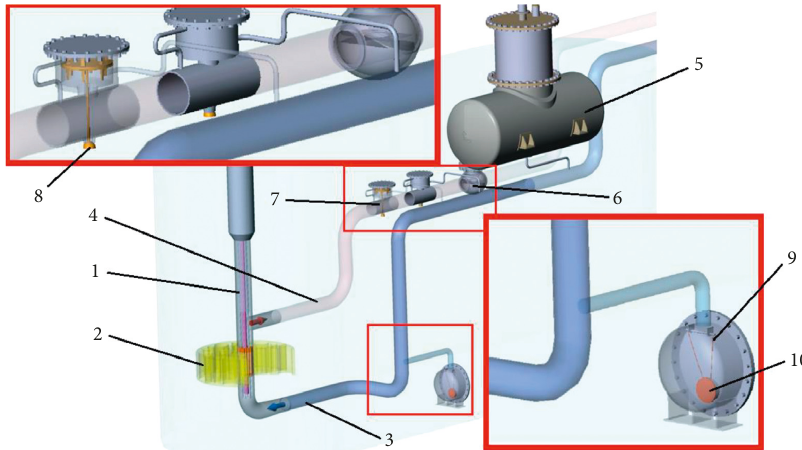
Figure 9: Appearance of equipment for the transition to natural circulation through the pool: (1) reactor vessel; (2) neutron reflector; (3) pressure pipeline of the primary circuit; (4) outlet “hot” pipeline; (5) pressure compensator, ECCS tank; (6) check valve; (7) discharge valve of natural circulation of the primary circuit into the pool; (8) outlet valve coolant outlet channel; (9) inlet valve of natural circulation of the primary circuit; (10) coolant inlet channel from the pool.